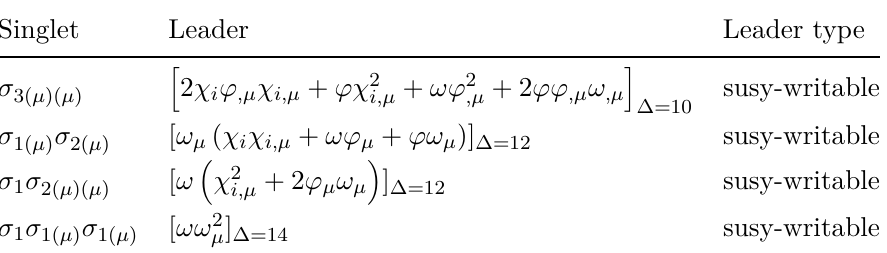
Table 4 . Scalar leaders with N φ = 3 , N der = 2 in d = 8